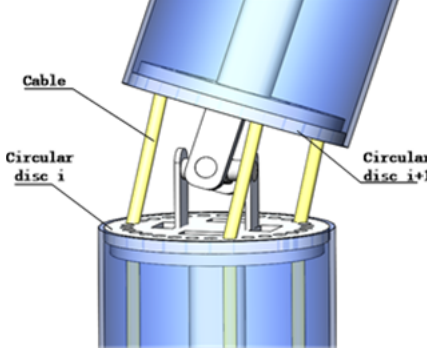
Figure 3. Joint of a hyper-redundant manipulator.